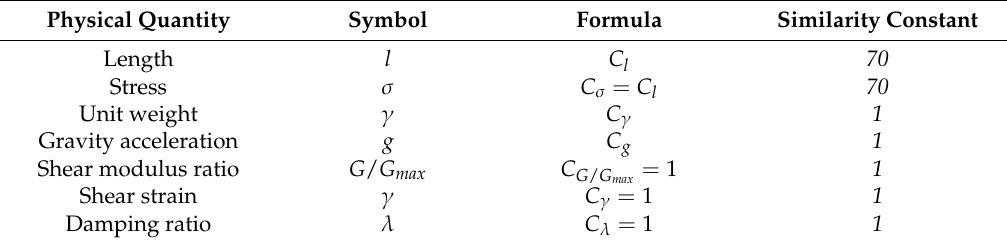
Table 3. Similarity constants of geotechnical model.